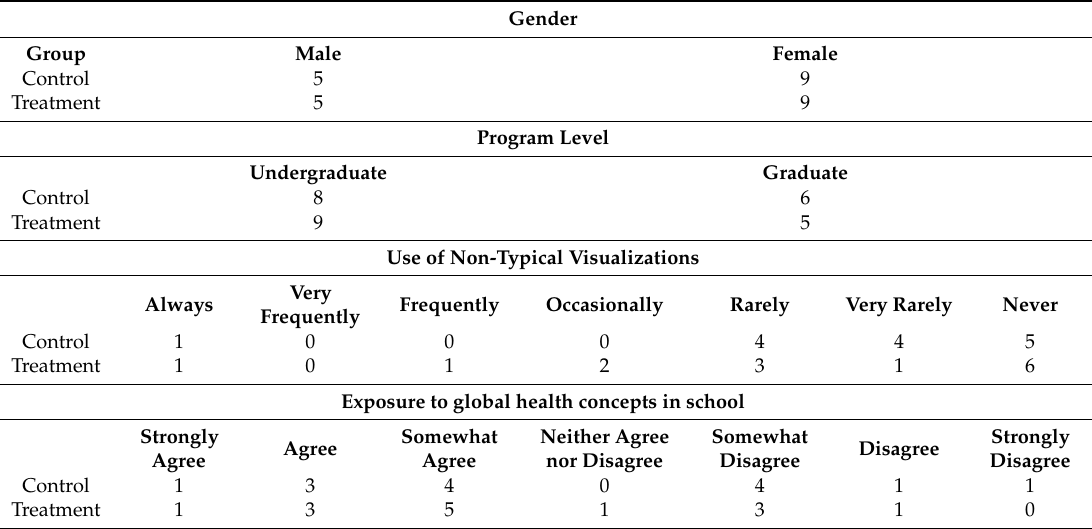
Table 5. Summary of participant demographics for health literacy